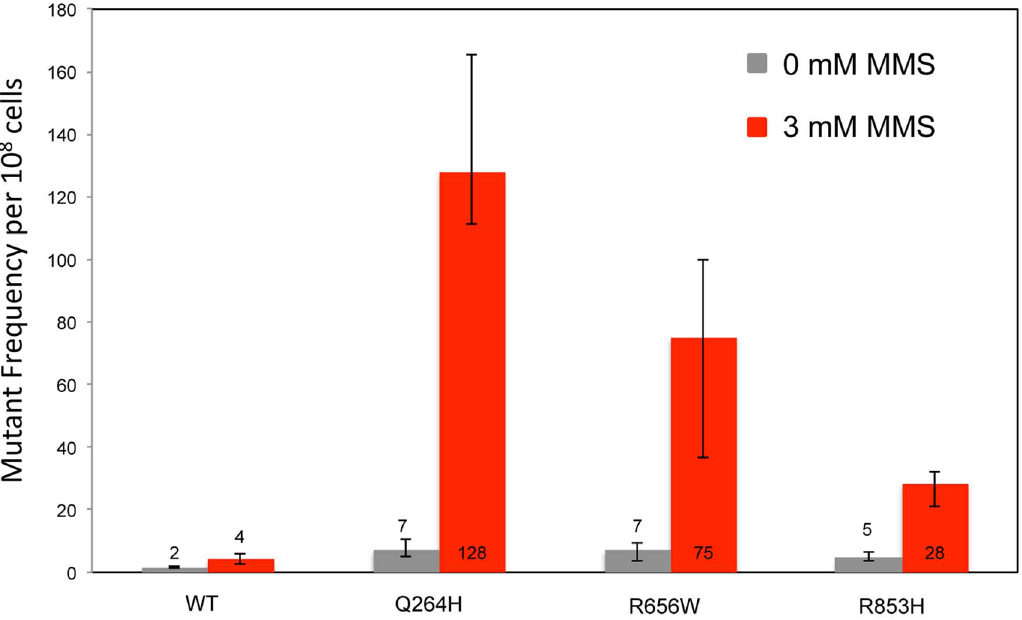
Figure 1. Methyl methanesulfonate exposure increases mtDNA point mutagenesis in heteroallelic strains encoding Mip1 variants. Median frequency ( 6 95% CI) of erythromycin-resistant mutants per 10 8 rho + cells of haploid strains with wild type MIP1 encoded in the chromosome and a centromeric plasmid encoding MIP1 or mip1 with various disease-associated mutations in the presence (3 mM) or absence (0 mM) of MMS. Mutant frequencies were determined from 40 (for R656W and R853H) and 80 (for MIP1 and Q264H) independent cultures from at least 2 separate experiments. CI, confidence interval; MMS, methyl methanesulfonate; mtDNA, mitochondrial DNA.